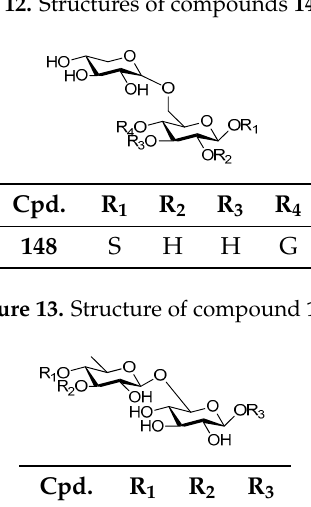
Cpd. Figure 14. Structure of compound 149 .